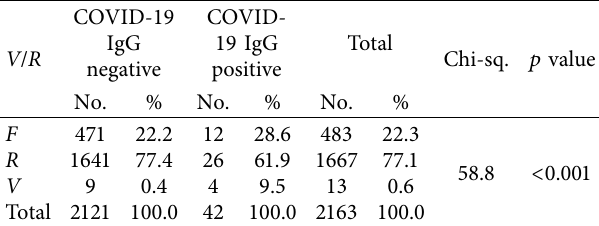
Table 4: COVID-19 IgG positive status among blood donors according to the category of blood